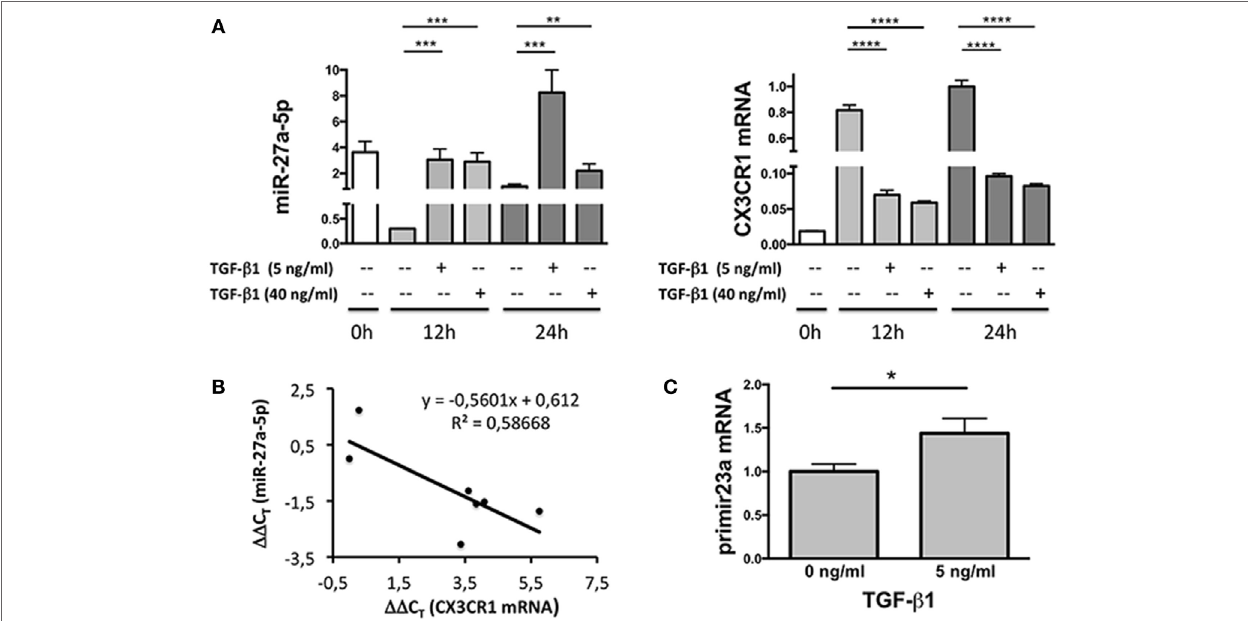
FigUre 3 | Expression profile of miR-27a-5p and CX 3 CR1 mRNA in TGF- β 1-treated natural killer (NK) cells. (a) NK cells treated for 12 or 24 h with the indicated amounts of TGF- β 1 were simultaneously analyzed for the expression of miR-27a-5p and CX 3 CR1. RNU44 and GAPDH were used as reference controls, respectively. Data in quadruplicate from one representative donor (donor 1), of two analyzed (donors 1 and 4), are shown. Expression relative fold changes are referred to the expression of miR-27a-5p and CX 3 CR1 mRNA in untreated NK cells (medium alone, 24 h) whose expression has been arbitrarily assigned the value 1. ** p < 0.01, *** p < 0.001, **** p < 0.0001. (B) Correlation between miR-27a-5p and CX 3 CR1 mRNA expression in TGF- β 1-treated NK cells. Scatter plot showing miR-27a-5p and CX 3 CR1 mRNA expression in TGF- β 1-treated NK cells from the same donor (donor 1) of ( a ). Each point represents the miR-27a-5p and CX 3 CR1 expression detected in one of the seven reported conditions, with different TGF- β 1 concentrations (0, 5, and 40 ng/mL) and time of treatment (0, 12, and 24 h). The trendline, its equation and the R 2 value is reported. Significance of correlation was determined using the Pearson’s coefficient ( r = − 0.765948064, p < 0.05). Data are referred to a representative donor (donor 1), of two analyzed (donors 1 and 4). (c) miR-23a-27a-24-2 cluster primary transcript expression in TGF- β 1- treated NK cells. NK cells cultured for 24 h in the presence or absence of 5 ng/mL of TGF- β 1 were analyzed by real-time PCR for the expression of miR- 23a~27a~24-2 cluster primary transcript. GAPDH was used as reference control. Data in triplicate from one representative donor of three analyzed (donors 5, 6, and 7) are shown. Expression relative fold changes are referred to the expression of untreated NK cells (medium alone) whose expression has been arbitrarily assigned the value 1. * p <